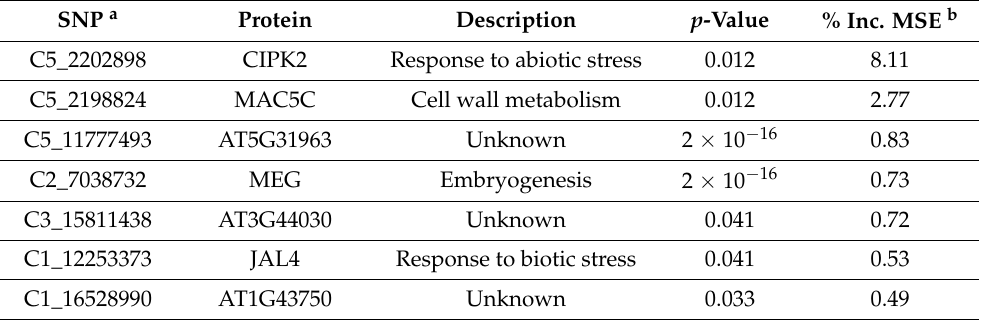
Table 2. SNPs significantly associated with CMV seed transmission rate according to Random For-